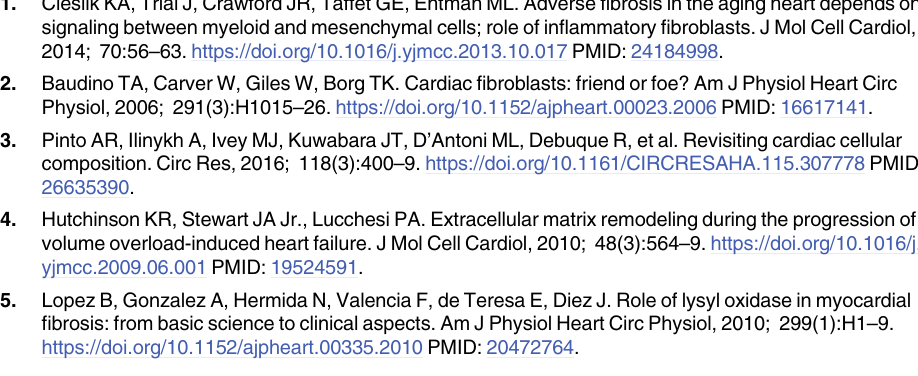
S1 Table. Oligonucleotide sequences of custom-designed primers for quantitative